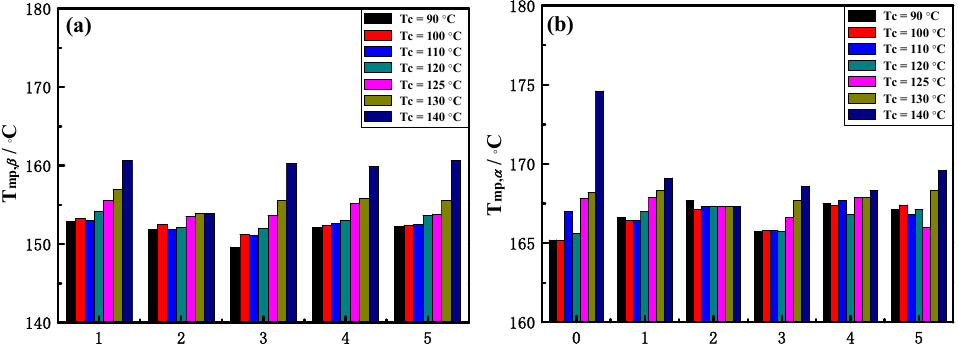
Figure 5. The peak melting temperatures ( a ) T mp, β and ( b ) Tmp, α . The horizontal axis numbers 0-5 correspond to pure iPP, iPP/0.1TMB-5 UT , iPP/0.1TMB-5 DMSO , iPP/0.1TMB-5 DMF , iPP/0.1TMB-5 ODCB and iPP/0.1TMB-5 LP , respectively.